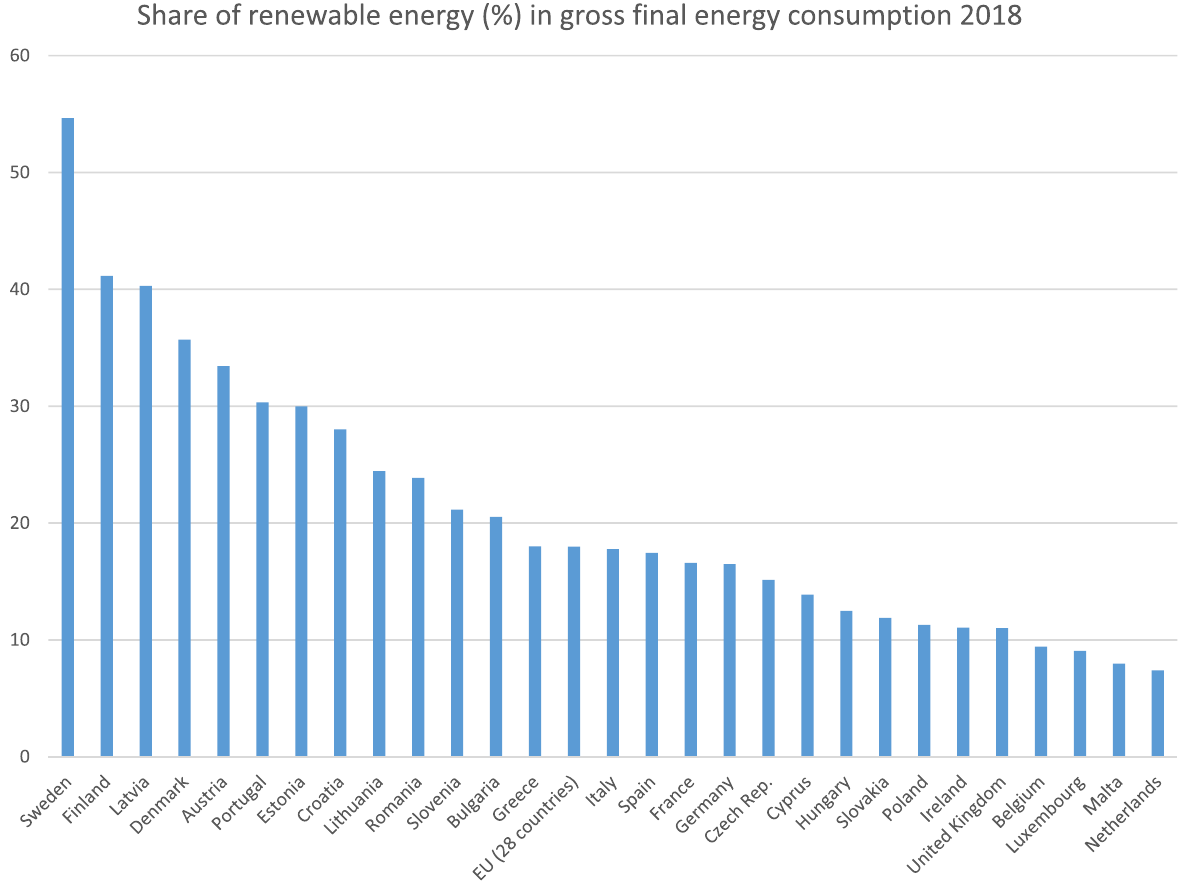
Fig. 1 Share of renewable energy in gross final energy consumption for EU-28 in 2018 (source: Eurostat